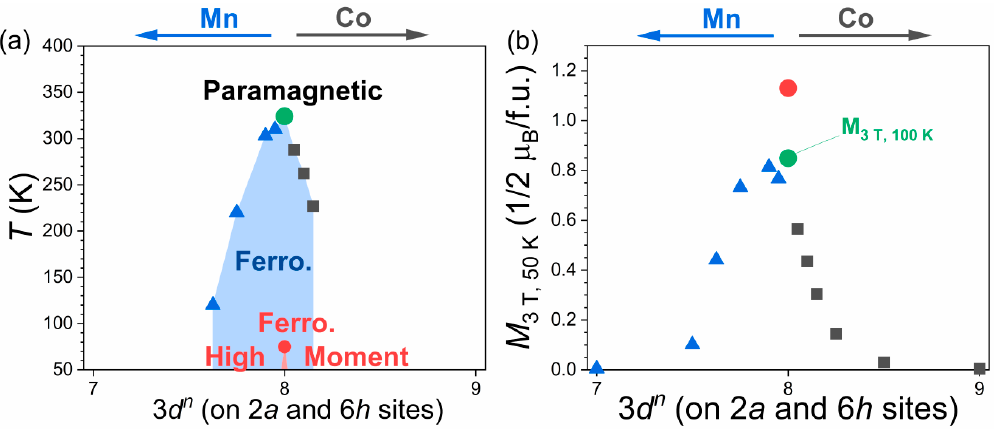
( a ) Transition temperatures for Sc 0.28 Ti 0.72 Fe 2 − y Mn y and Sc 0.28 Ti 0.72 Fe 2 − x Co x alloys; ( b ) magnetization at 3 T and 50 K for Sc 0.28 Ti 0.72 Fe 2 − y Mn y (triangles) and Sc 0.28 Ti 0.72 Fe 2 − x Co x (squares). For Sc 0.28 Ti 0.72 Fe 2 , the T t1 transition temperature and the magnetization above T t1 are also indicated